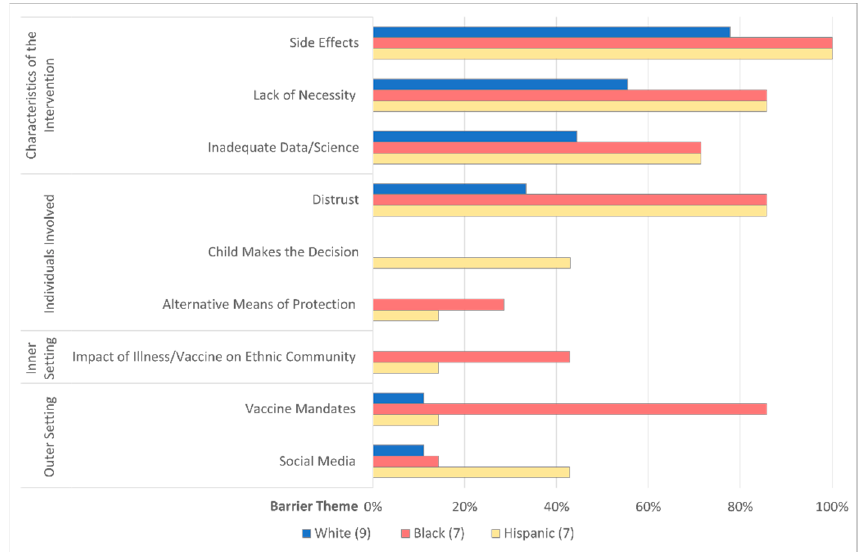
Figure 3. Vaccine Barrier Themes Differ by Race and Ethnicity. Vaccine barrier themes are organized by Consolidated Framework for Implementation Research (CFIR) domains. The bar graph compares the frequency each barrier theme occurred in White, Black, and/or Hispanic participants.